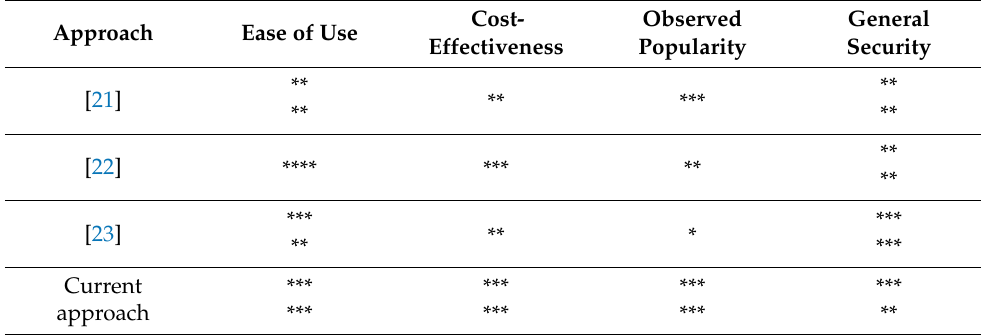
Table 6. Comparison between some of the related research and proposed work. Approach Ease of Use